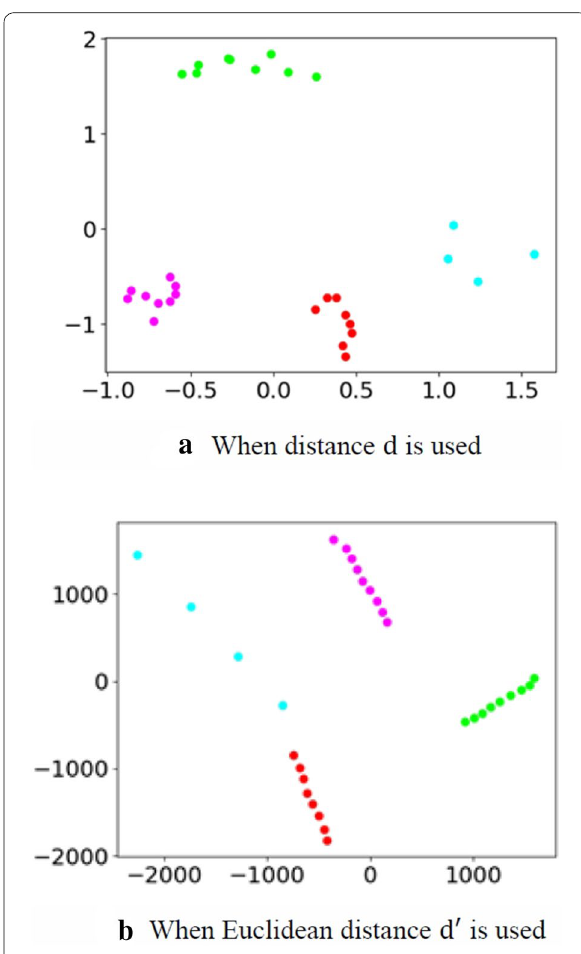
Fig. 12 BB vector distributions. The colors of the points correspond to the colors of the BBs in Fig. 8a